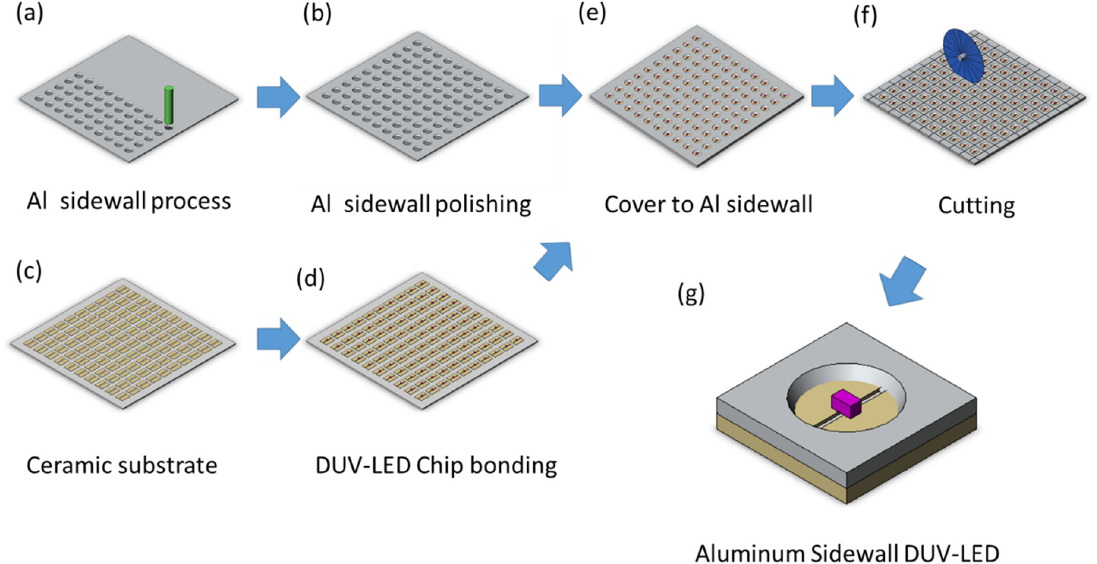
Figure 9. Procedure used to fabricate ( a , b ) aluminum sidewall and ( c , d ) bonding DUV-LED on the ceramic substrate; ( e – g ) the aluminum plate holes was covered to obtain the ultraviolet LEDs are completed by optimizing the diameter and tilt of the aluminum sidewall.